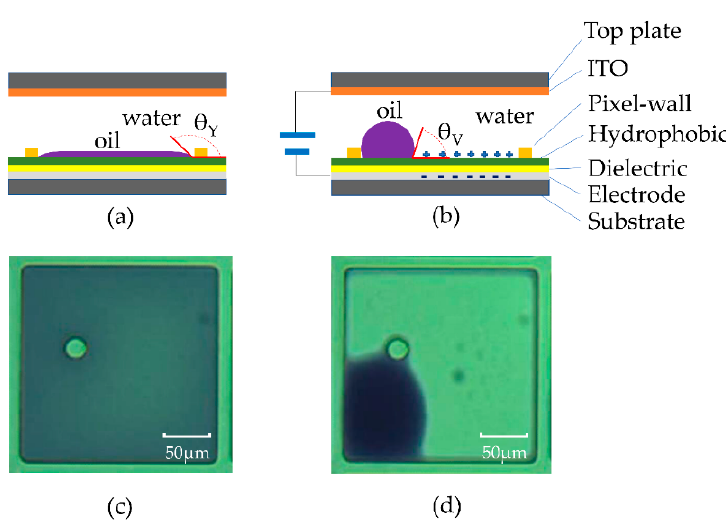
Figure 1. Schematic of electrowetting display and images of a tested sample. ( a ) Without voltage applied, a homogeneous oil film is present, showing the colored off-state. ( b ) With voltage applied, the oil film contracts, showing the white on-state. ( c , d ) The corresponding top view micrographs demonstrate a typical oil relaxation and contraction of a pixel. The size of the square pixel is 200 µ m × 200 μ m.